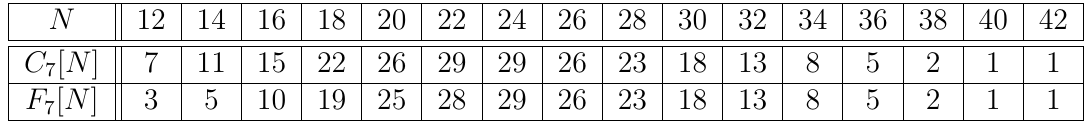
Table 5: Number of potentially (row C degree sequences of length 7 with given degree sum N .